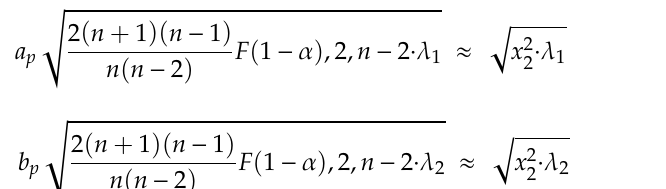
Figure 3. Representation of the SEA and PEA in a SSG small (32 m × 23 m).